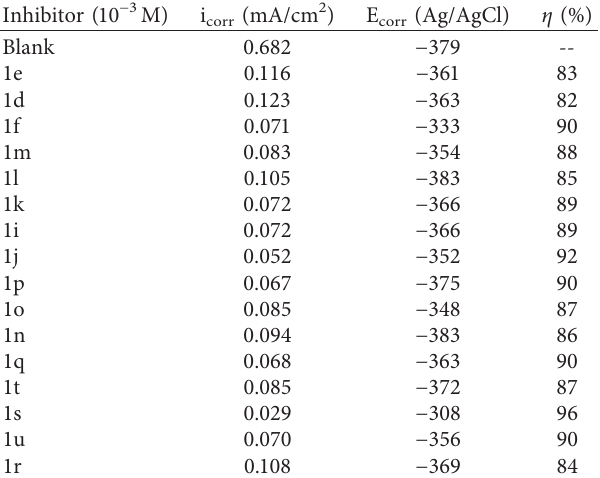
Table 5: Electrochemical parameters of steel in 1M HCl with and without different compounds at 10 − 3